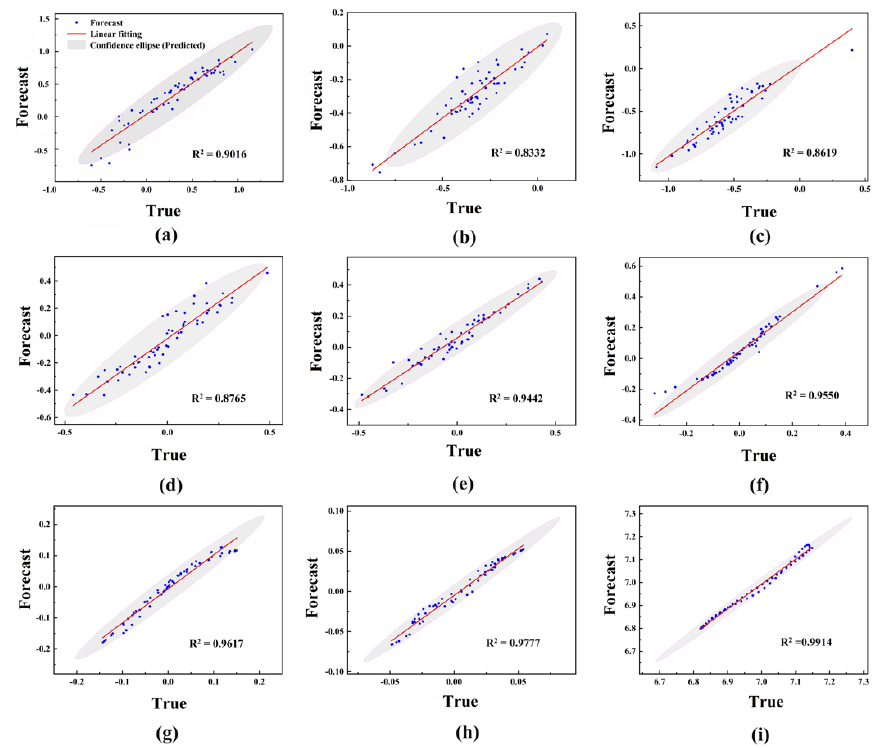
Figure 5. R 2 between predicted and true values of each component. ( a – i ) correspond to the results of components IMF1-IMF9, respectively. Table 1. RMSE, MAE, and R 2 values for each IMF component.